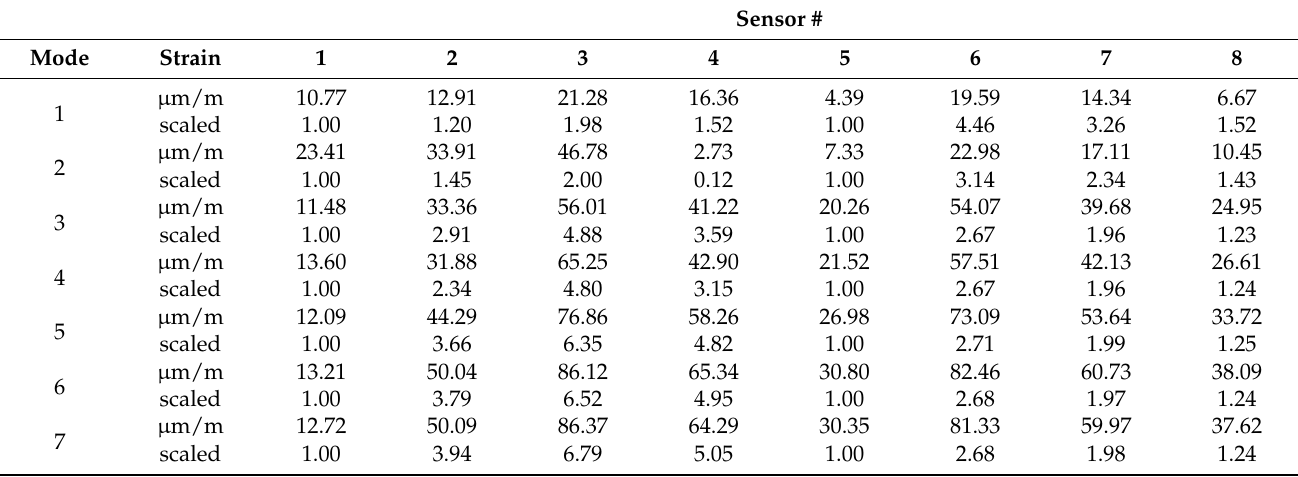
Table A1. Strain sensor data for the undamaged plate excited with 1 V amplitude.